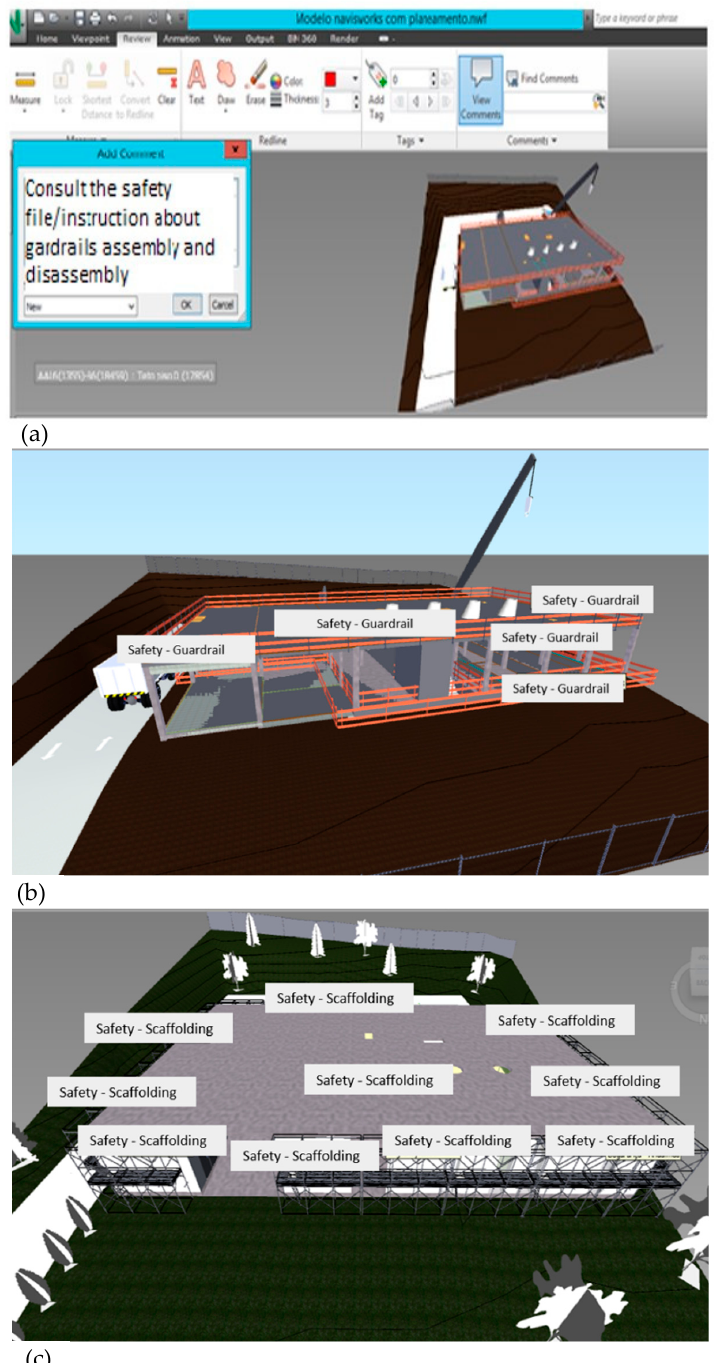
Figure 5. Links to comments ( a ) and safety files about guardrail ( b ) and scaffolding ( c ) assem-